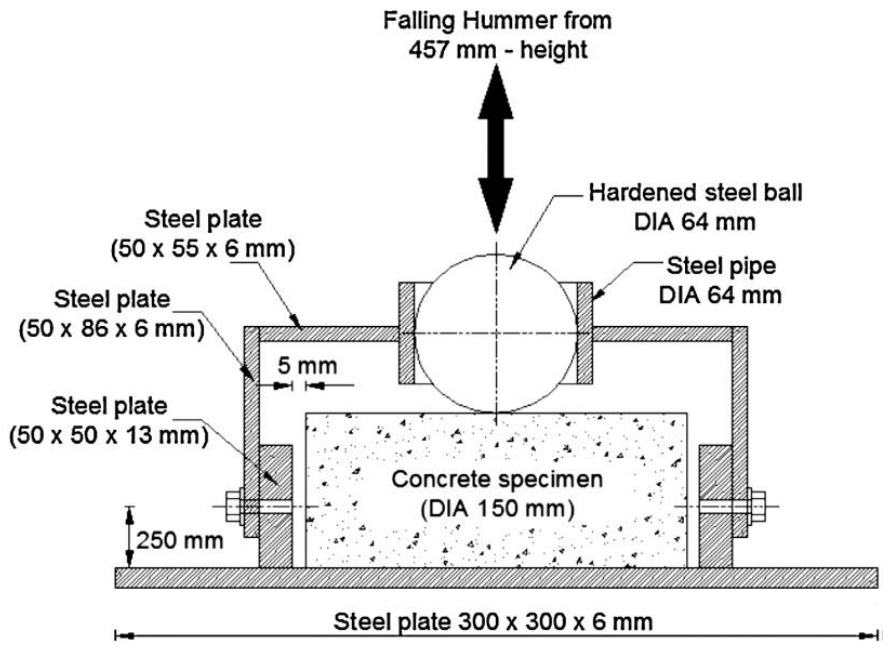
Figure 5. Test rig for impact energy measurement [15].